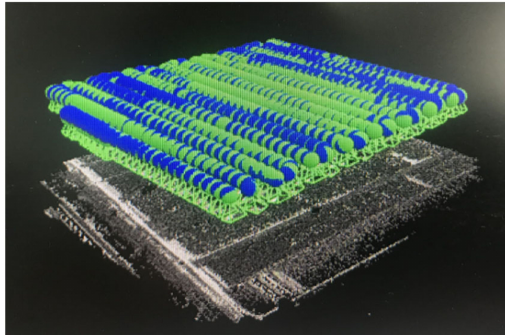
Figure 2. Flight path and rejection of invalid images.